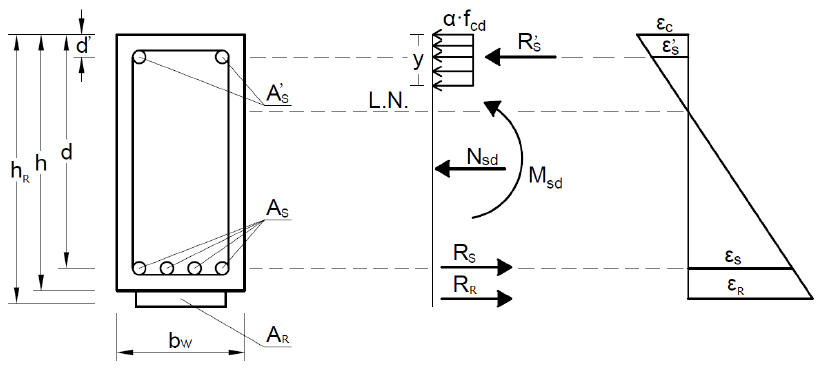
Figure 2. Stress and strain diagram for a section in the strengthened